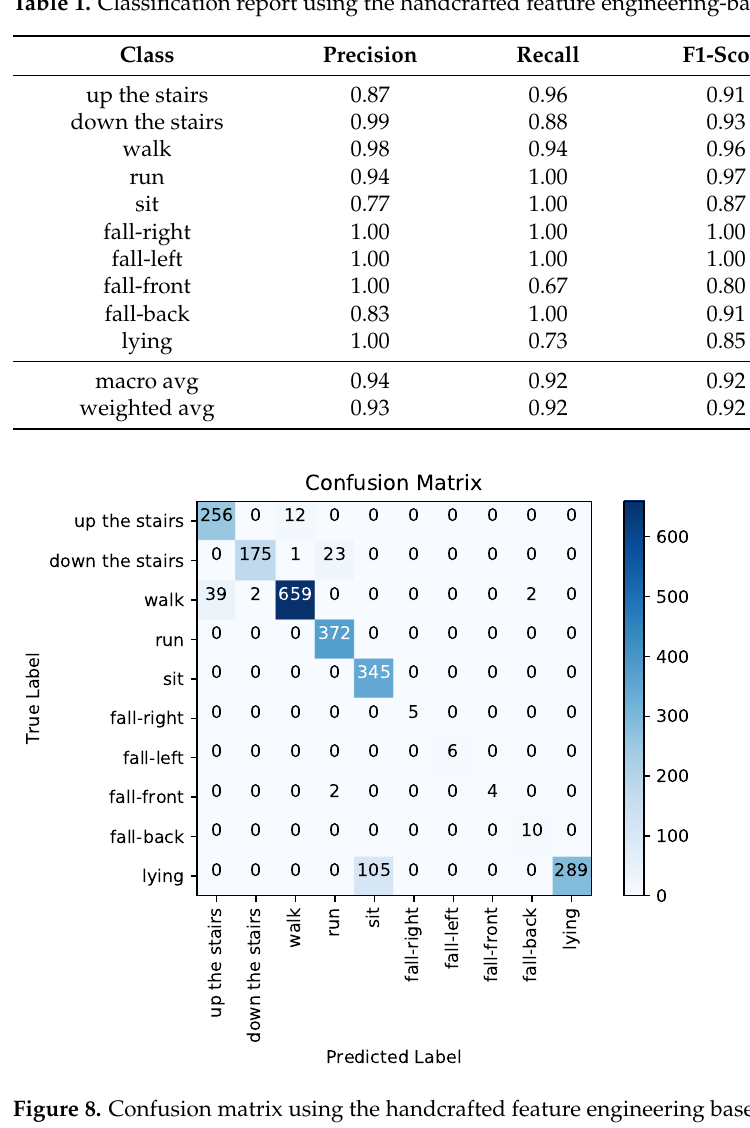
Figure 8. Confusion matrix using the handcrafted feature engineering based